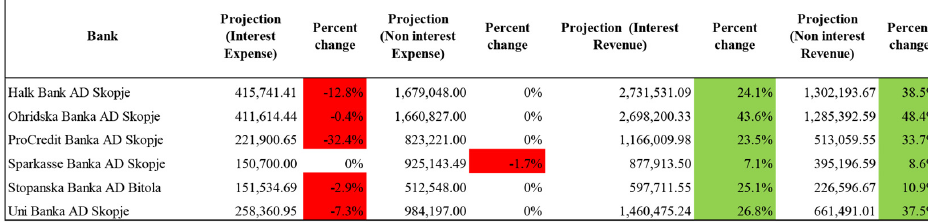
Figure 4. Targets for improvement for the inefficient Macedonian commercial banks (in 000 MKD Denars).